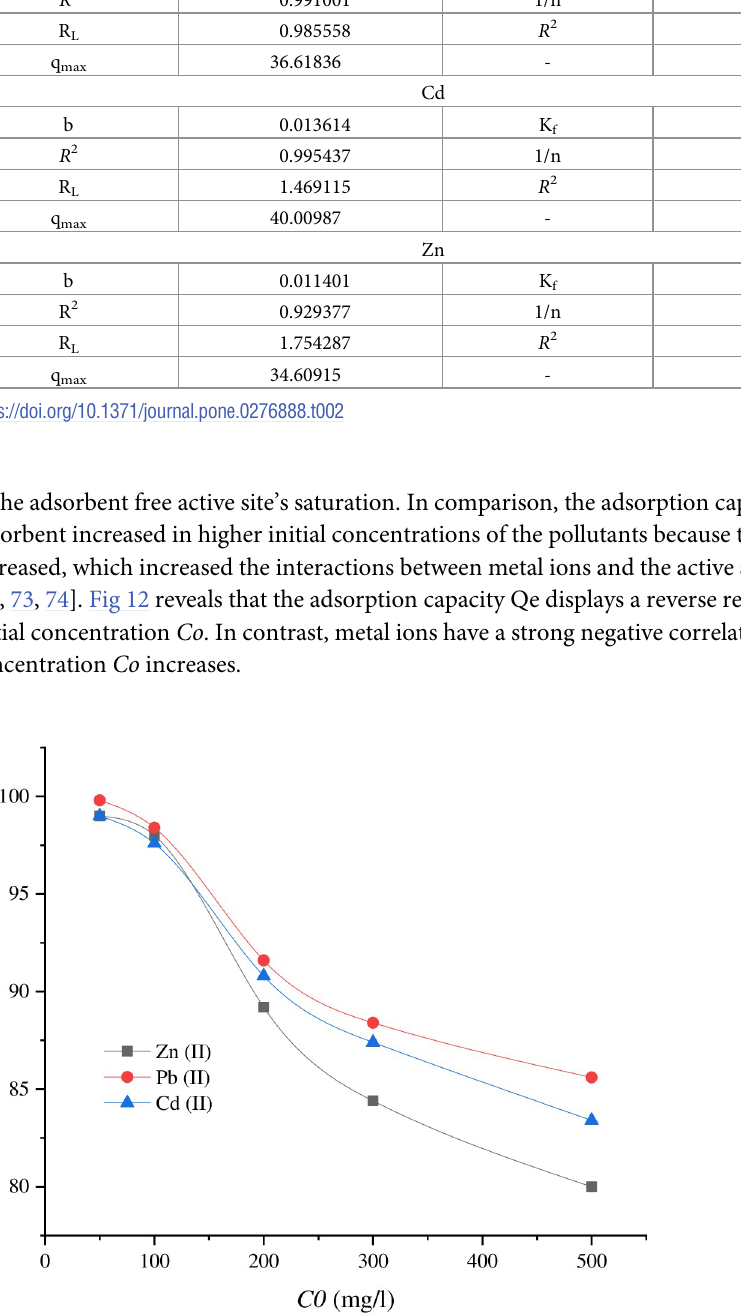
Fig 12. Adsorption capacities of SnCaAl 2 O 3 nanoparticles as a function of Zn +2 , Pb +2 , and Cd +2 ions concentration at constant adsorbent dose, contact time, and volume of polluted water.